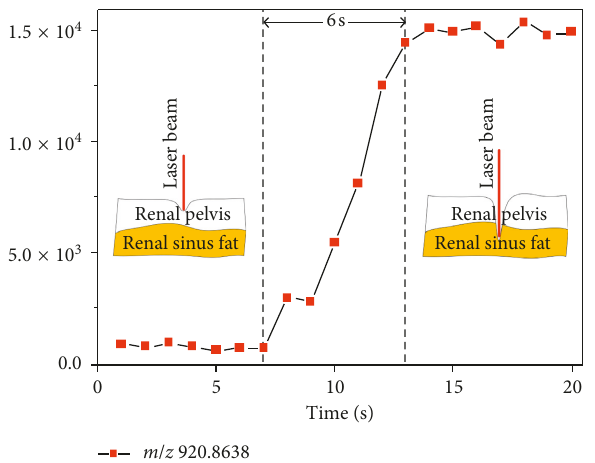
Figure 5: Response time for margin assessment was less than 6s.